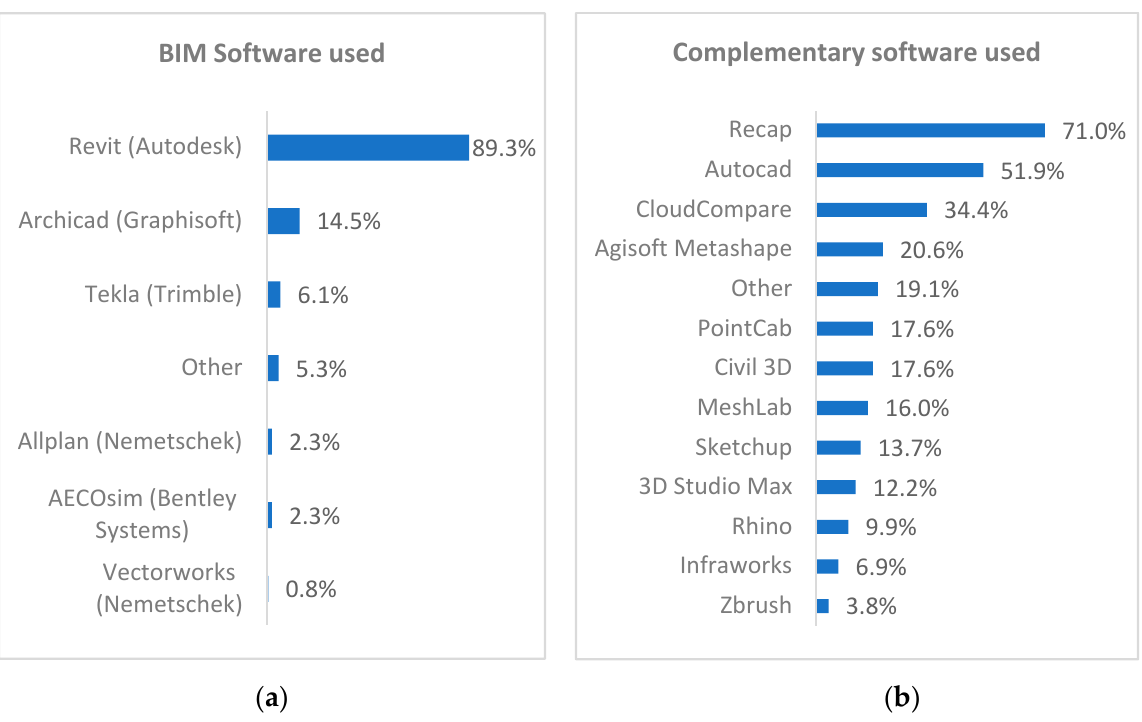
ISPRS Int. J. Geo-Inf. 2021 , 10 , x FOR PEER REVIEW